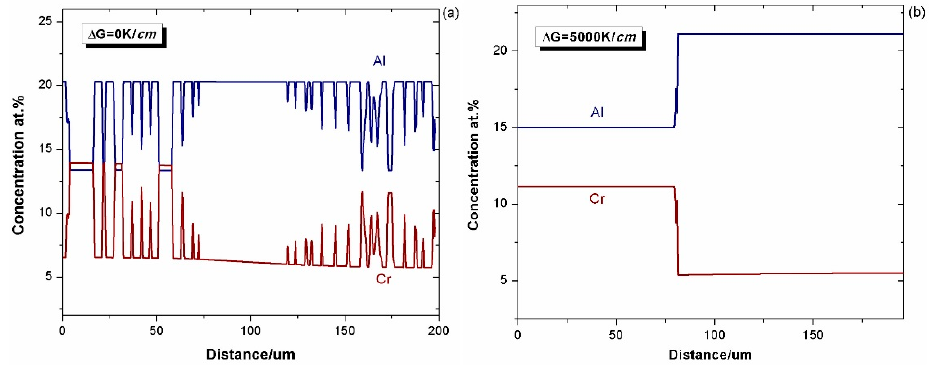
Figure 6. Composition distribution of Al and Cr in No. 1 γ + γ '/ γ + γ ' bond coat/substrate system (Ni–18at.%Al–12at.%Cr/Ni–19at.%Al–5at.%Cr) annealed ( a ) at 1373 K and ( b ) with an effect of temperature gradient Δ G = 5000 K/cm at 880,000 s.